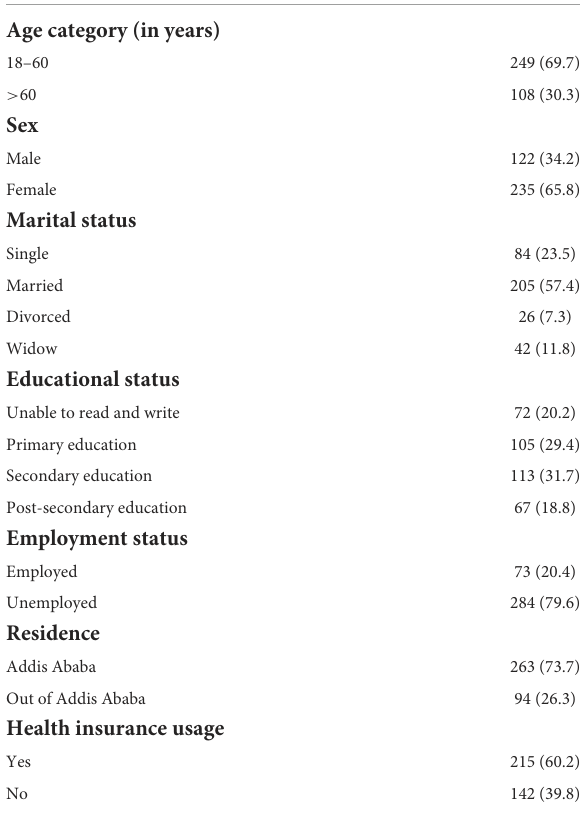
TABLE 1 Sociodemographic characteristics of patients with cardiovascular disease.